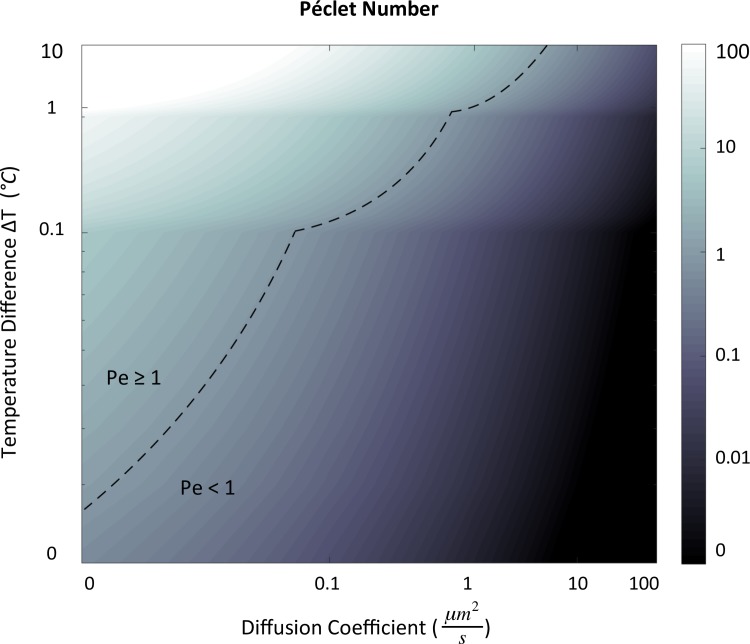
Péclet number (u*L/D) as a function of the temperature difference ΔT (Tmax−Tmin,°C) and the diffusion coefficient D (μm2/s), demonstrating regions in which Pe>1 and thus convection can theoretically dominate over diffusion.